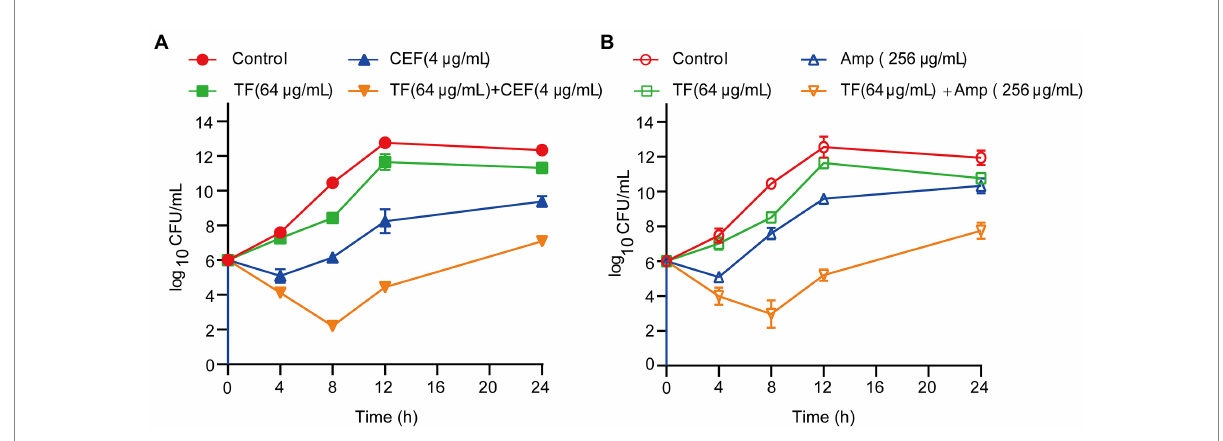
FIGURE 4 Time-killing kinetics of TF in synergistic combination with an antibiotic (CEF or Amp) against S. aureus USA300. (A) Time-killing kinetics of TF combined with CEF against S. aureus USA300. (B) Time-killing kinetics of TF combined with Amp against S. aureus USA300. Data represent 3 independent experiments